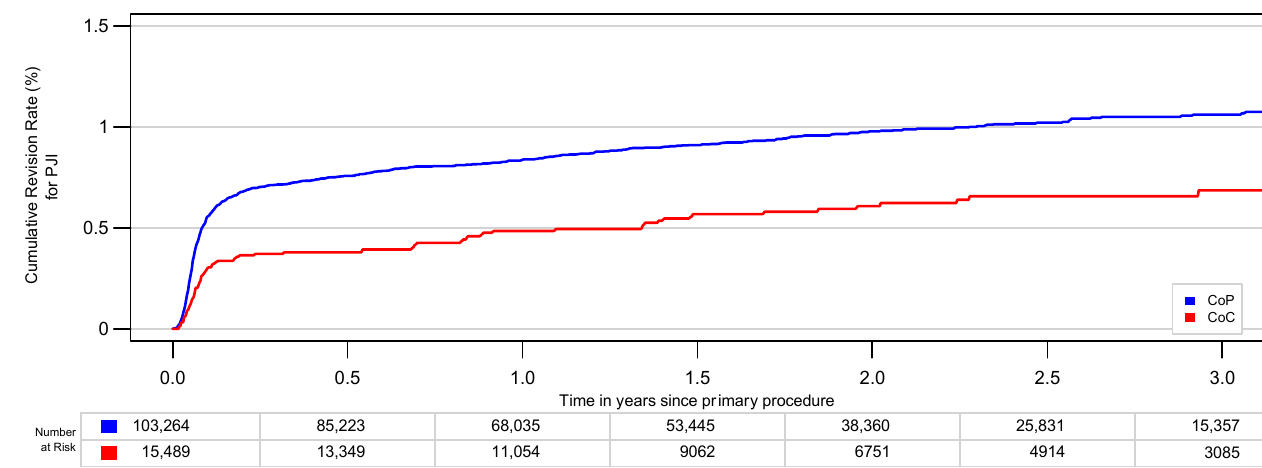
Figure 2. Cumulative risk of revision for periprosthetic joint infection (PJI) of ceramic-on-polyethylene (CoP) and ceramic- on-ceramic (CoC) bearings before matching ( p < 0.01).